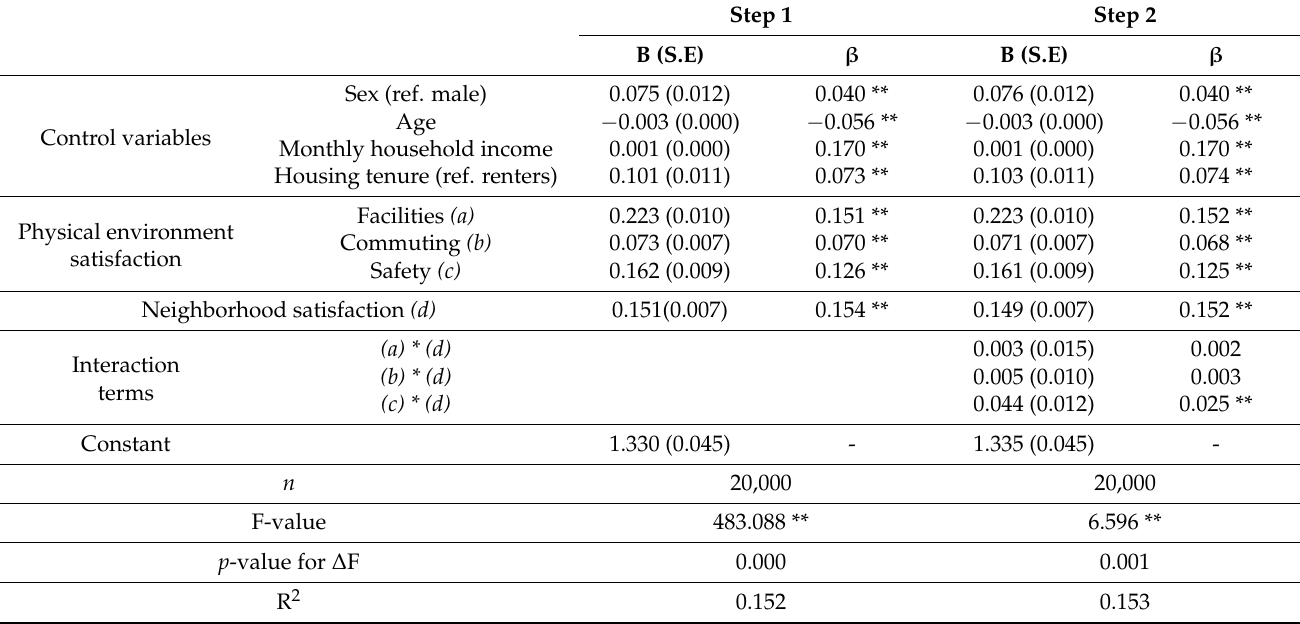
Table 4. Moderating effect